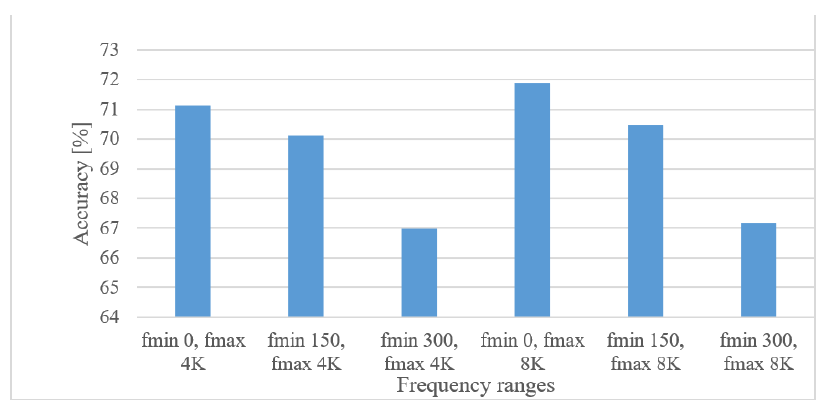
Figure 9. Averaged accuracies for minimal and maximal frequency limits.